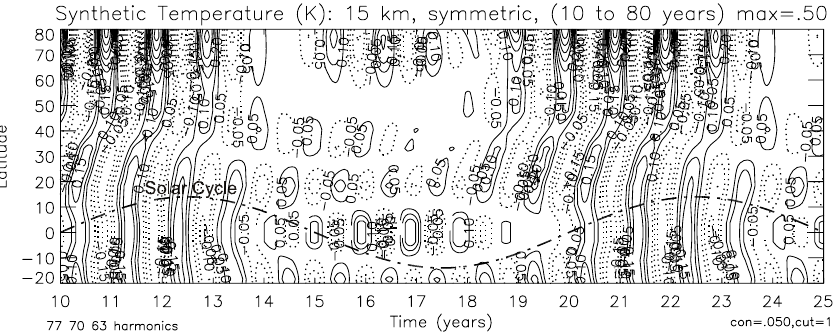
Fig. 10. Similar to Fig. 8 but for the temperature variations at 15km, which are associated with the symmetric EAO zonal winds. In contrast to the zonal wind oscillations (Fig. 8a), which are confined to equatorial latitudes due to wave mean flow interactions, the associated temperature variations extend to high